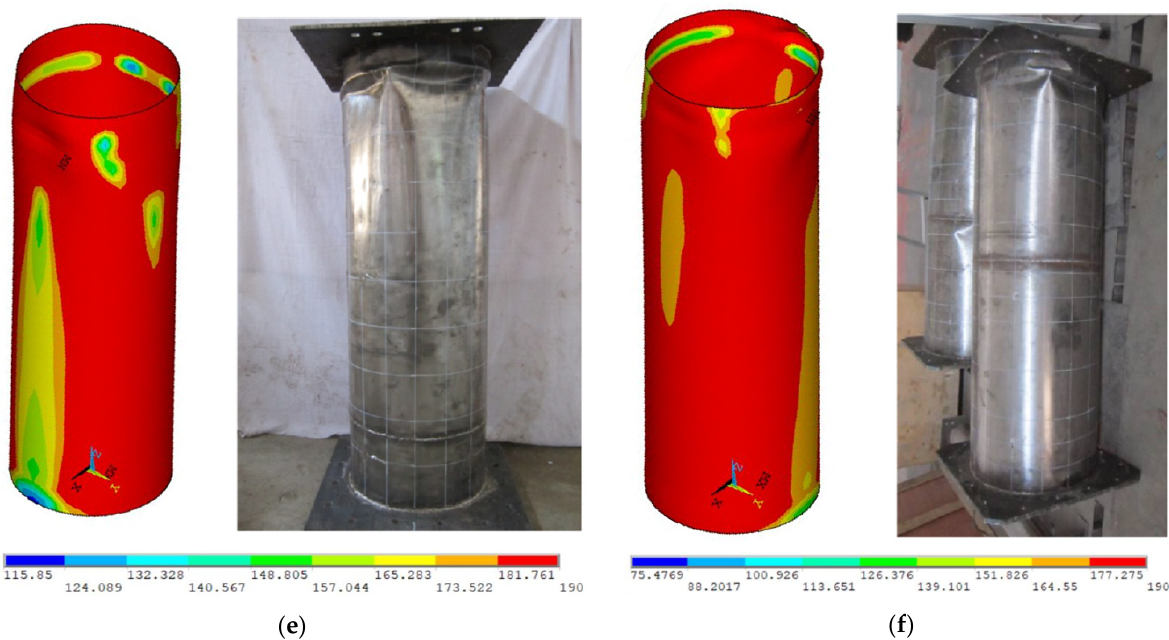
Figure 6. Comparison between failure phenomena resulting from FEA by authors and the experi- mental tests by Lanhui Guo et al. (Reprinted from Ref. [13]) for specimens with 𝐷 𝑡⁄ ranging from 75 to 300. ( a ) 𝐷 𝑡⁄ = 75 . ( b ) 𝐷 𝑡⁄ = 100 . ( c ) 𝐷 𝑡⁄ = 125 . ( d ) 𝐷 𝑡⁄ = 150 . ( e ) 𝐷 𝑡⁄ = 200 . ( f ) 𝐷 𝑡⁄ = 300 .